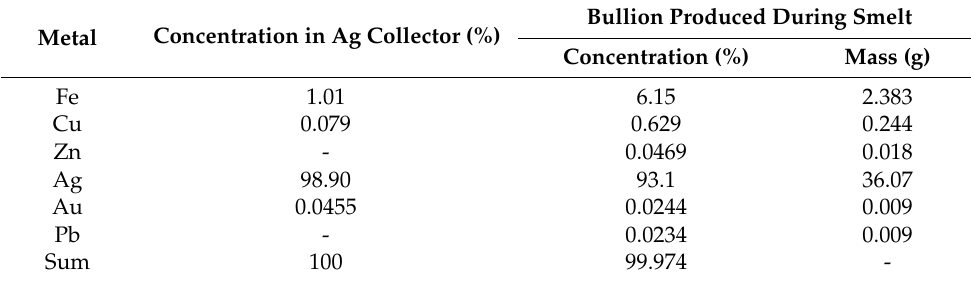
Table 4. Metal concentration in the silver and bullion determined by XRF and the calculated mass of metal in the final smelt product. Significant figures used for metal concentration based on the XRF limit of detection for each